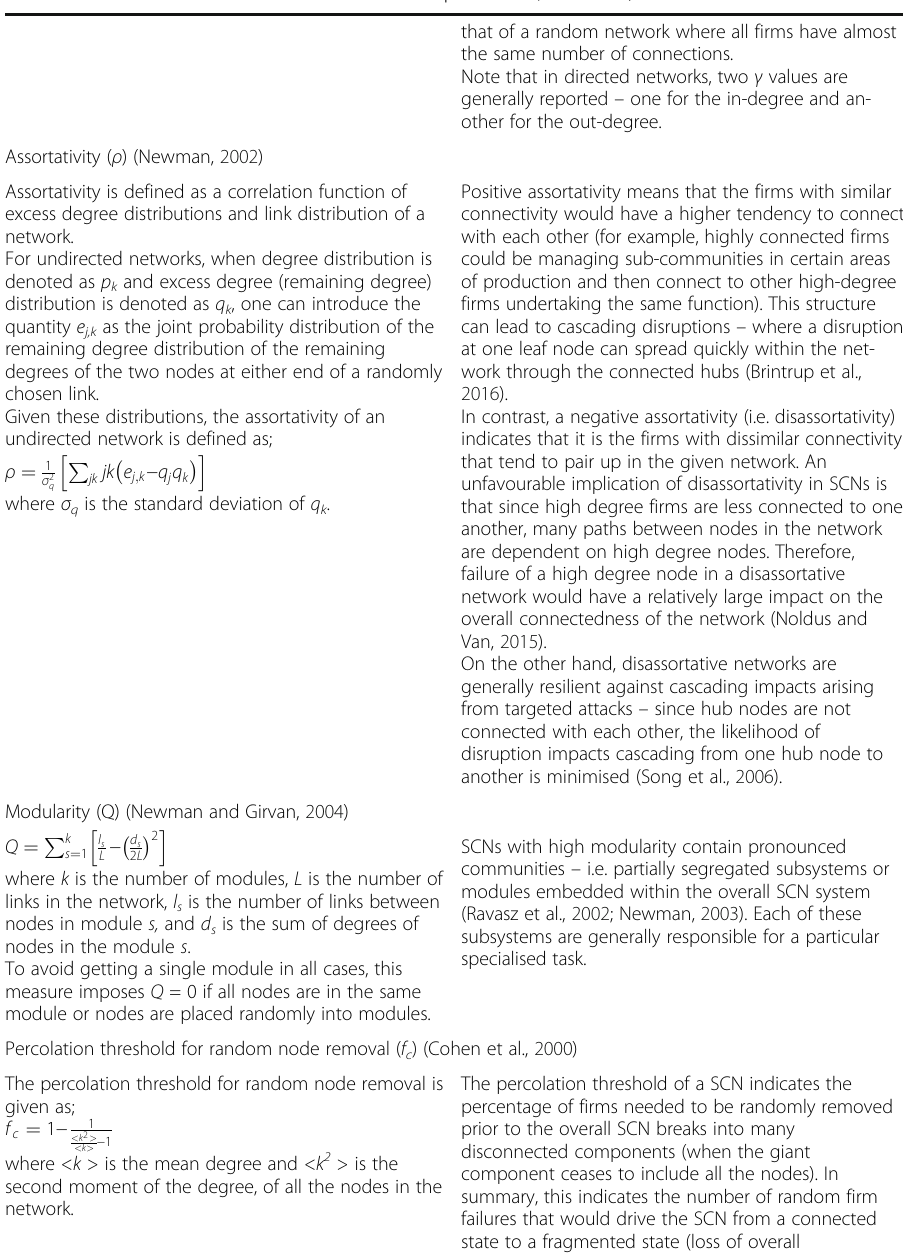
Table 4 Network level metrics and their SCN implications